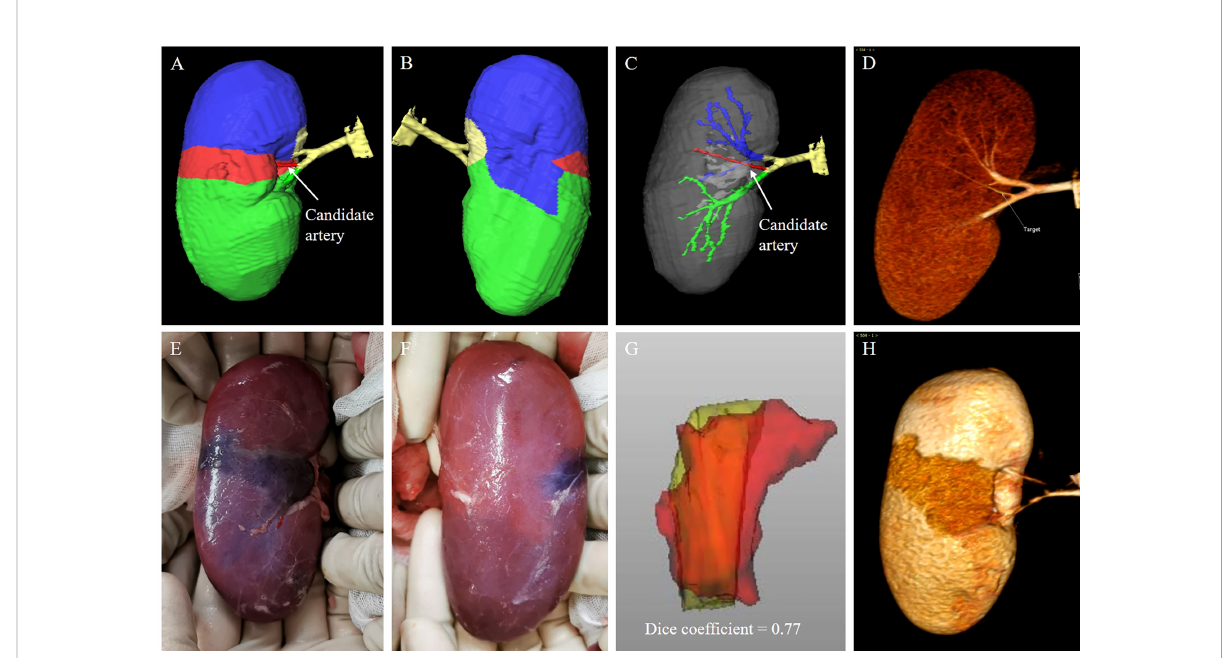
FIGURE 4 animal validation of the TKP model. (A – D) The TKP model of a porcine kidney is automatically established based on the fi rst CT scan, and a candidate segmental artery is selected. (E, F) The ischemic line on renal parenchyma is visible and recorded after the candidate segmental artery is ligated. (G, H) The second CT scan is performed and the similarity between the actual ischemia region from the second CT scan and the perfusion region from the TKP model is calculated using the algorithm of dice coef fi cient. In this case, the dice coef fi cient is 0.77.